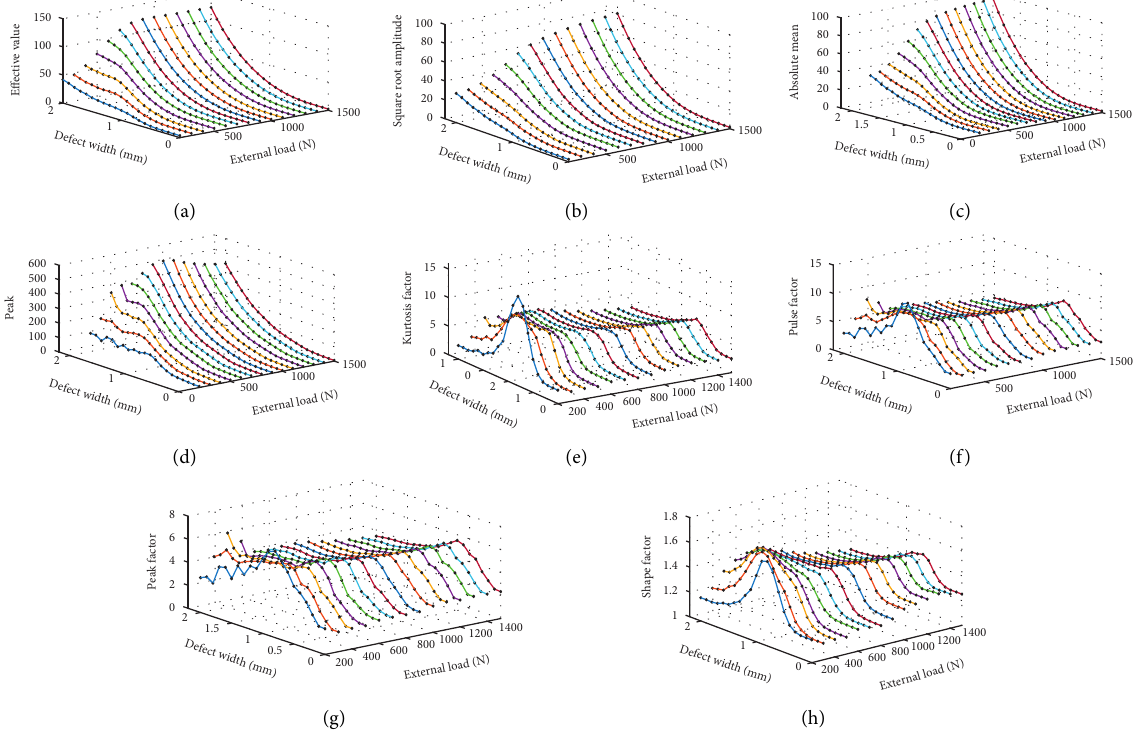
Figure 11: Effect of defect width on characteristic parameters under different external loads. (a) Effective value. (b) Square root amplitude. (c) Absolute mean value. (d) Peak value. (e) Kurtosis factor. (f) Pulse factor. (g) Peak factor. (h) Shape